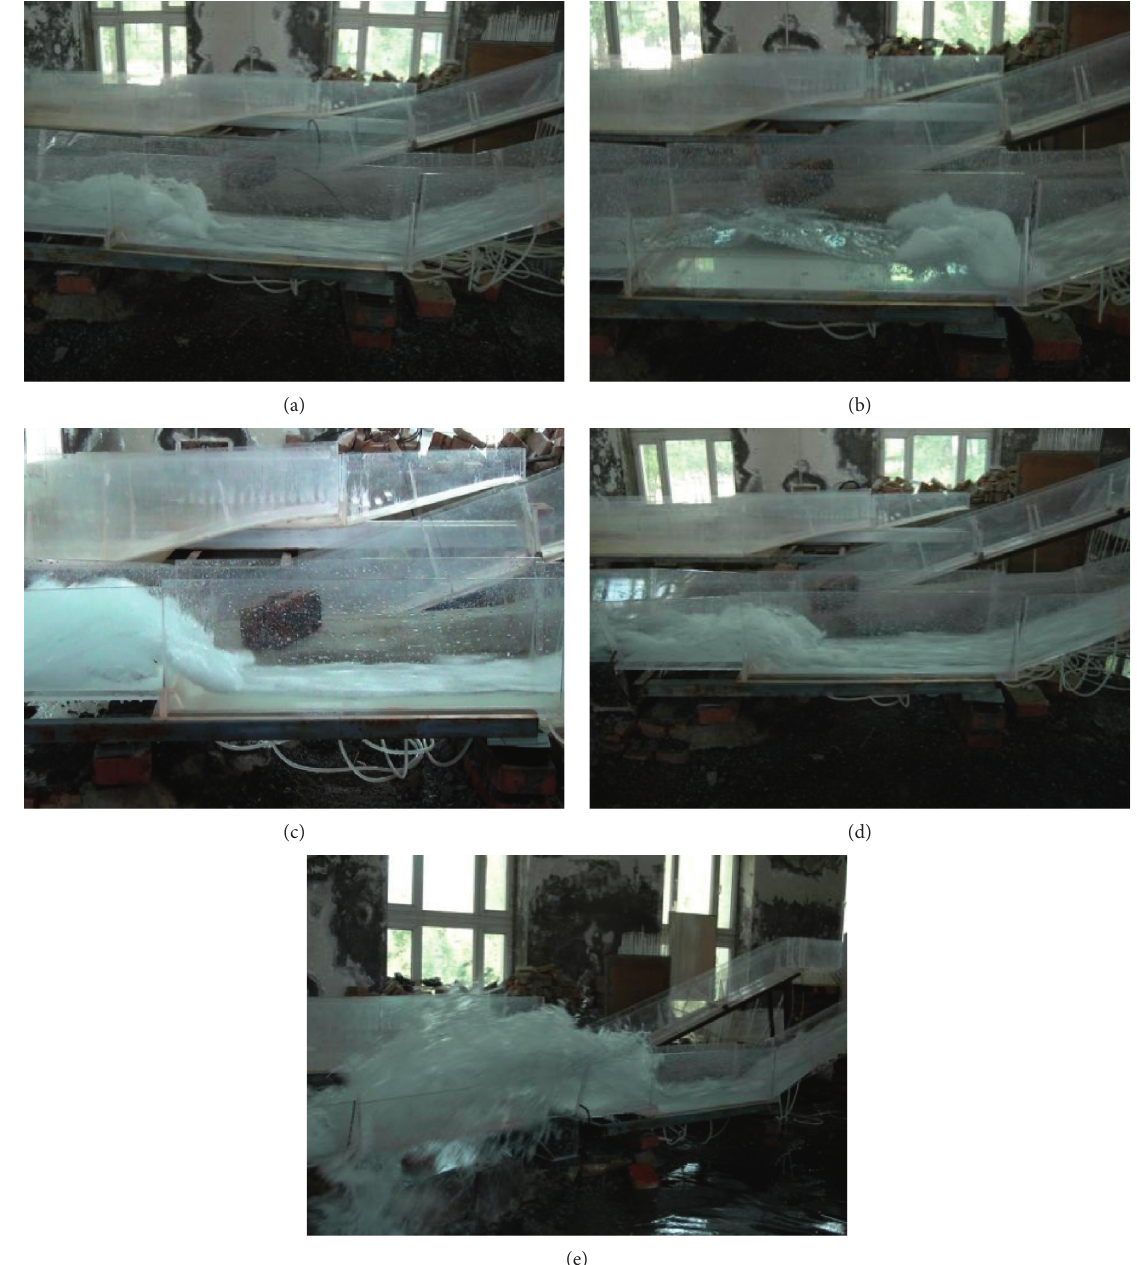
Figure 6: Flow state at the stilling pool section under different conditions. (a) Flow state under a 10-year flood. (b) Flow state under a 20-year flood. (c) Flow state under a 30-year flood. (d) Flow state under design flood condition. (e) Flow state under collated flood